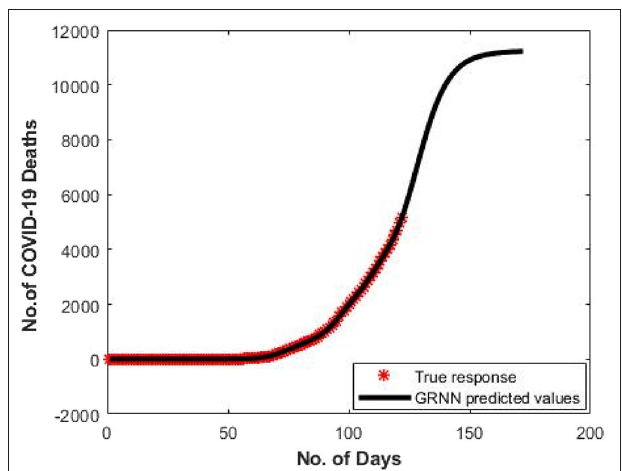
FIGURE 7 | Predicted curve for D1 using